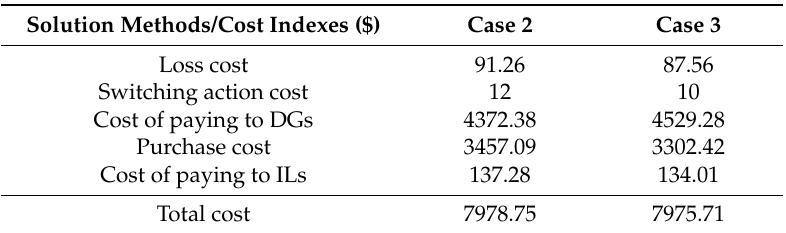
Table 4. Cost comparisons between case 2 and case 3.